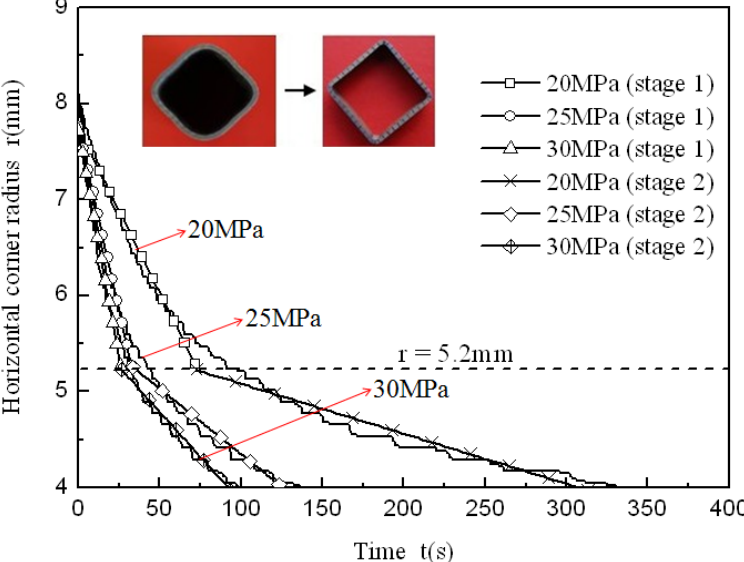
Figure 6. Corner filling curves at three different pressure levels which are linearly fitted.